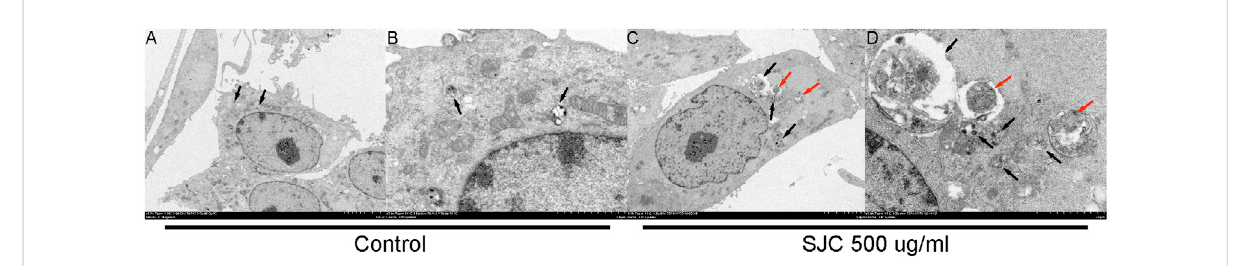
FIGURE 9 Autophagosome were observed under a transmission electron microscope. (A , B) were the normal control group, and there were some autophagolysosomes in early digestion stage. (C , D) show cells from the 500 μ g/ml SJC treatment group, with many autophagosomes, mid-late autophagolysosomes, double-layer membrane structures, and no obvious organelle structures inside the cell. Autolysosomes are represented by black arrows and autophagosomes are represented by red